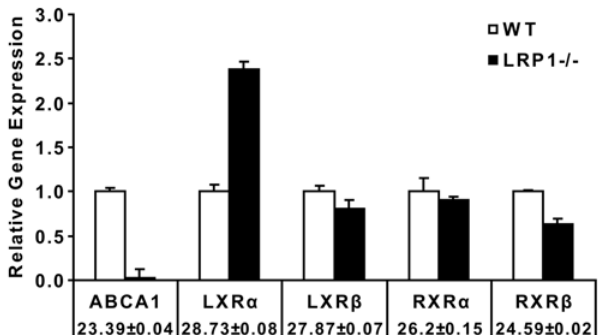
Figure 5. Quantification of LXR and RXR mRNA by real-time PCR in primary SMCs. 2 m g of total RNA from WT and LRP1 2 / 2 SMCs were prepared and subjected to real-time PCR quantification. Relative expression ratios represents the amount of mRNA in the LRP1 2 / 2 SMCs relative to that in the wild type cells, which was arbitrarily defined as 1. The number underneath each gene represented the wild type C T values 6 S.D. mRNA levels of the transcriptional regulators of ABCA1, namely LXRs and RXRs, in the LRP1 2 / 2 SMCs (black bars) were comparable to those in the wild type cells (white bars). Assays were performed in triplicate, standard deviations are shown.